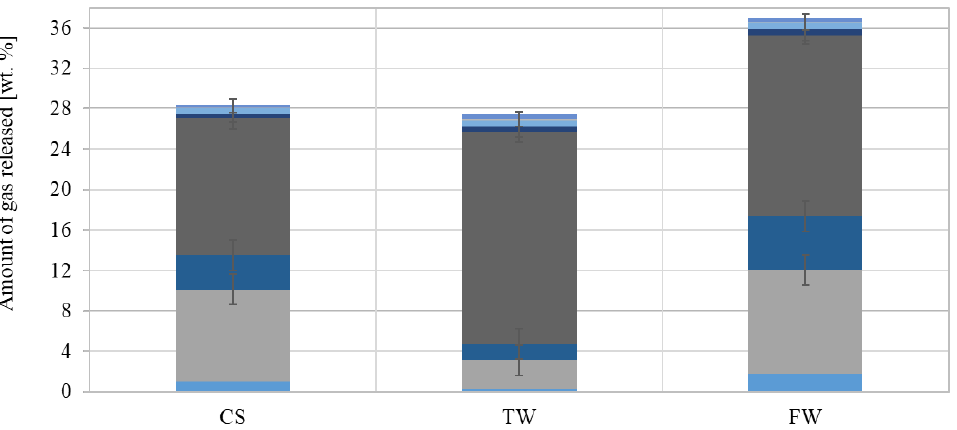
Figure 8. Amount of gas released at the same pyrolysis temperature from waste biomass feedstocks (CS, TW, and FW) (composition converted to oxygen-free and nitrogen-free conditions). The highest CO 2 concentration of approximately 21 wt% was determined in the gas samples obtained after TW pyrolysis. It is known that decarboxylation of cellulose and hemicellulose, and the possibility of volatile compounds occurring during the secondary reaction, produce CO 2 . However, compared to CO 2 , the amount of CO released was much higher, where FW was approx. 10.2 wt%. The measured hydrogen content of the studied samples revealed that FW was the highest content at approx. 2 wt%. This stemmed from the demethoxylation of lignin in the solid residue or from the release of volatile